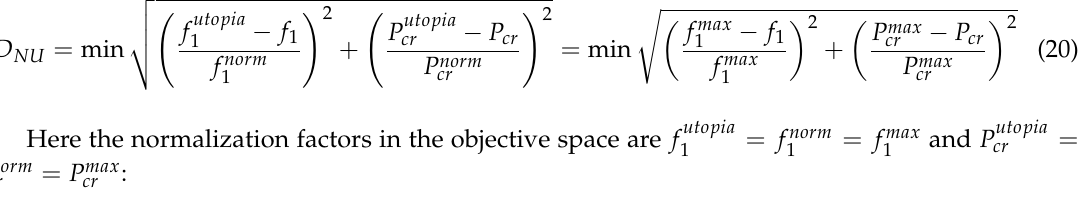
Table 2. Nadir points selected as the ones giving minimal Euclidean distance to UP, norm = max . Scaling Factors